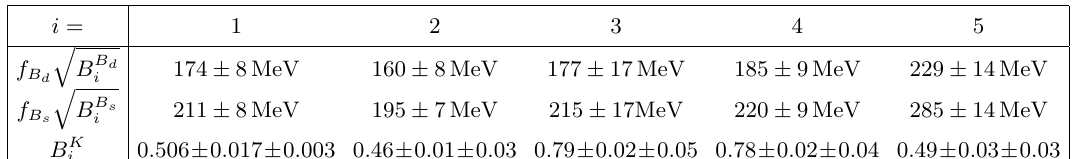
Table 2. Lattice determinations of f M